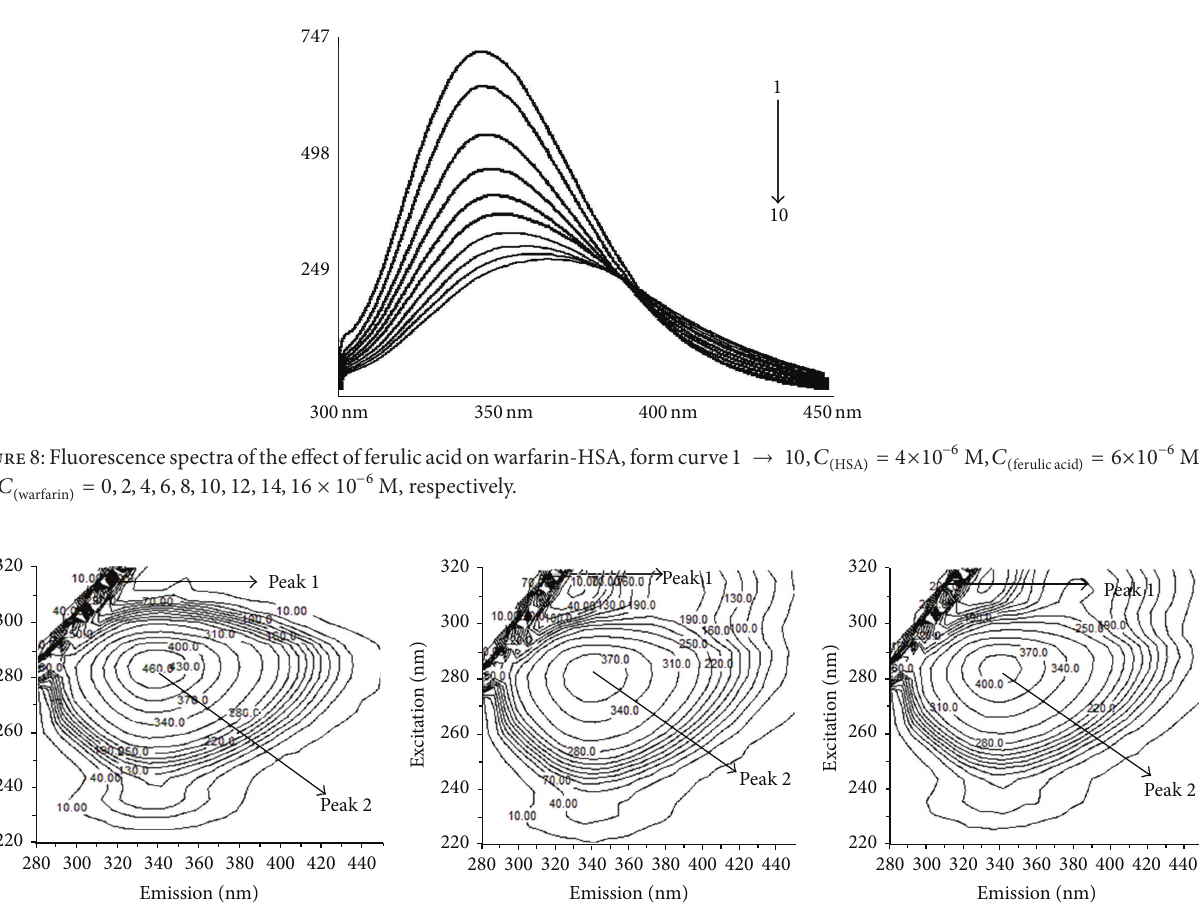
Figure 9: Contour spectra of (a) HSA, (b) HSA-warfarin, and (c) HSA-warfarin-ferulic acid. 𝐶 ( 6 × 10 −6